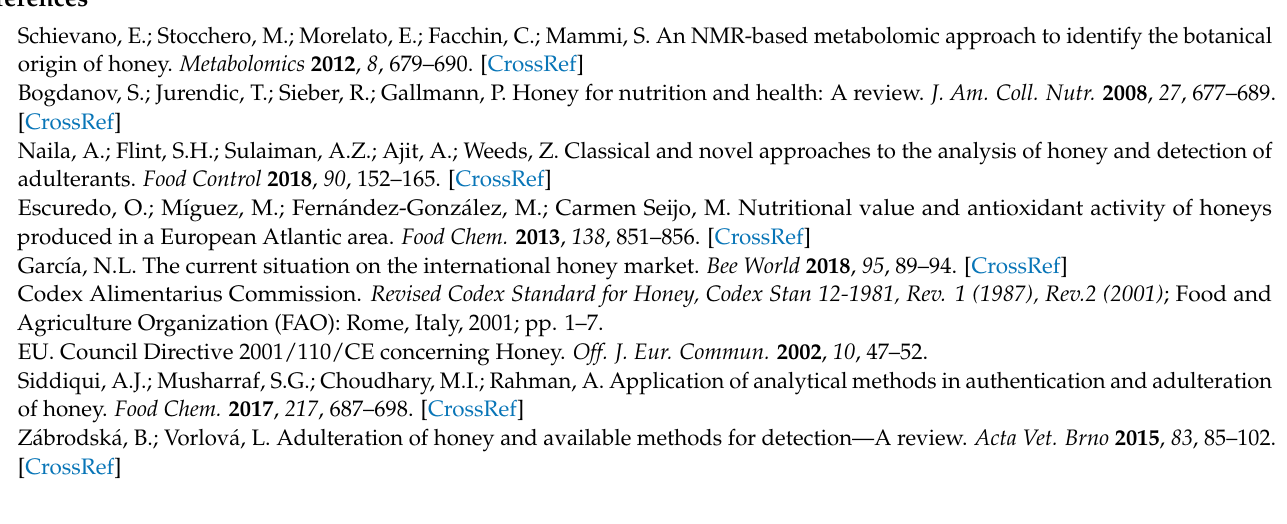
Table S1: Volatile profile of the honey samples obtained by solid-phase microextraction (SPME). The minimum and maximum values represent the lowest and highest percentages, respectively, of each identified component. Table S2: Volatile profiles of the honey samples obtained by hydrodistillation (HD). The minimum and maximum values represent the lowest and highest percentages, respectively, of each identified